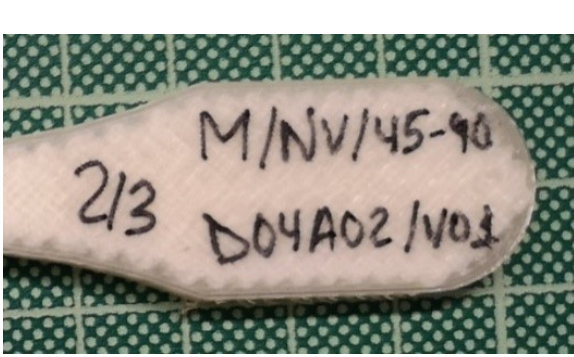
Table 4. Reference code.